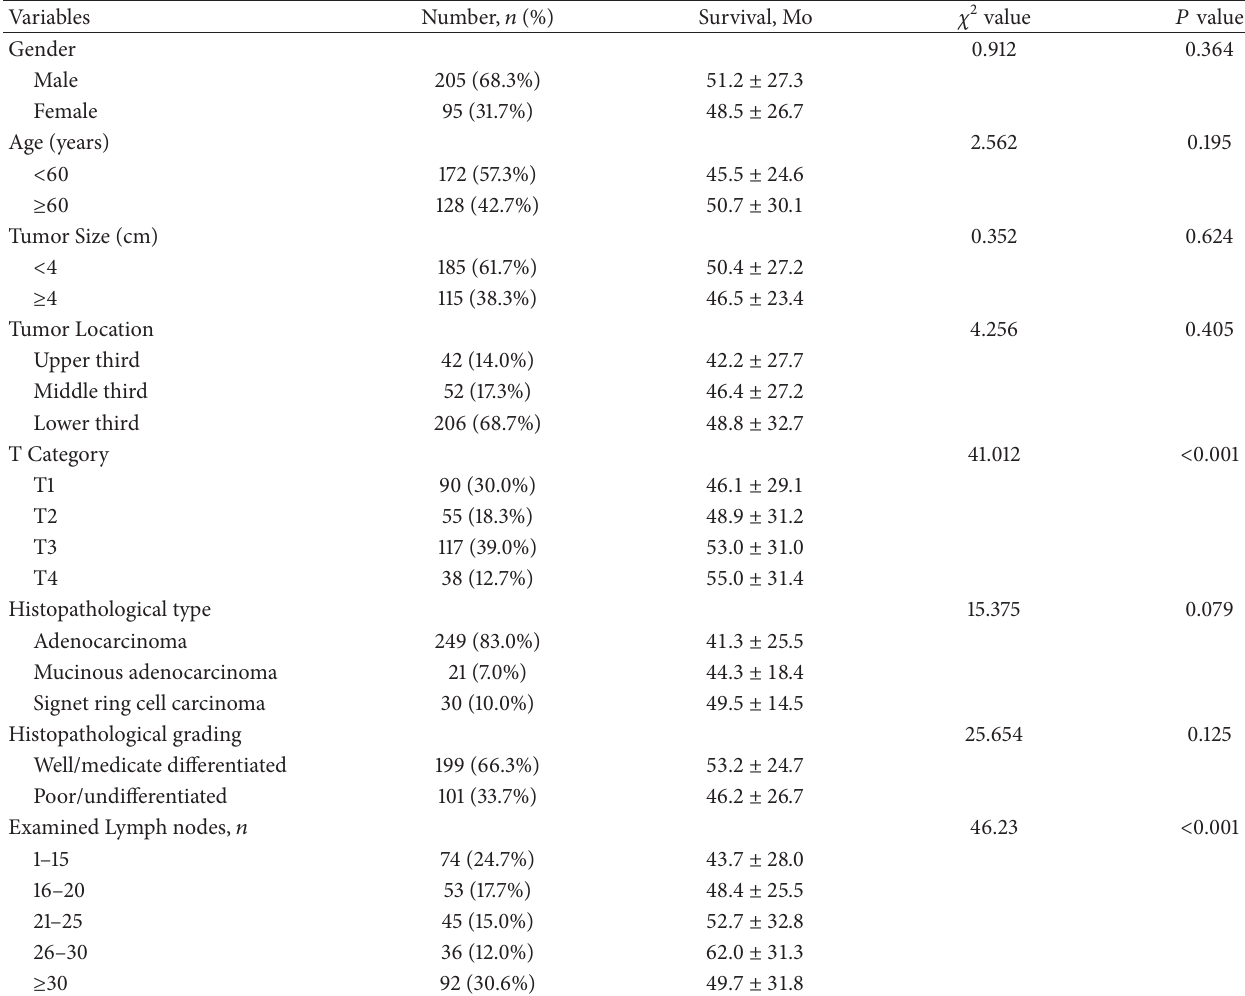
Table 1: Overall survival univariate analysis for predictive factors of survival.